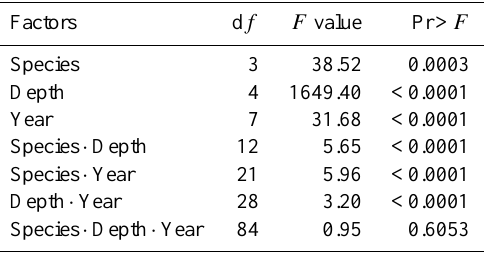
Table 2. Results of the ANOVA for soil organic carbon concentra- tion as affected by legume species, soil depth and experimental year. The bare soil plot is considered as a legume species in the analysis. The SAS PROC ANOVA was used in the analysis.